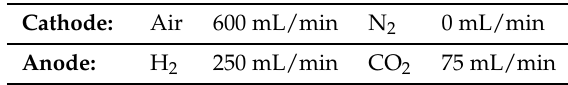
Table 1. Initial flow parameters for the oxygen depletion tests.